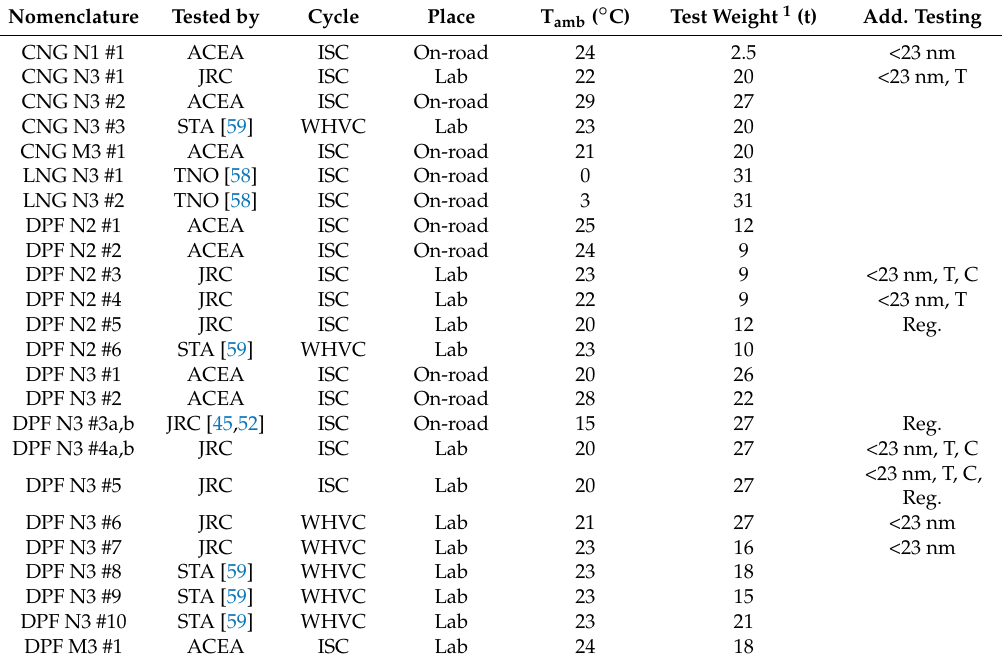
Table 2. Test details. More information in the main